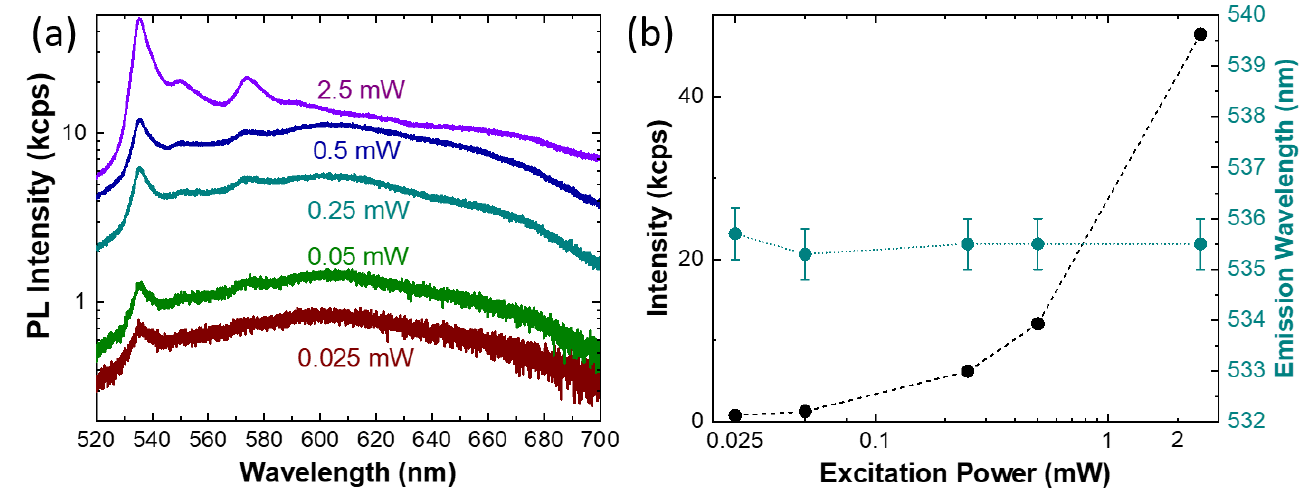
Figure 5. ( a ) PL spectra of the 15 keV electron-irradiated hBN with increasing 473 nm excitation power. ( b ) Power dependence of the 535 nm emission intensity (black symbols) and evaluation of the emission energy (cyan symbols), the lines are only a guide to the eye for the reader. Finally, the power dependence of the peak position reveals no shift in the emission.